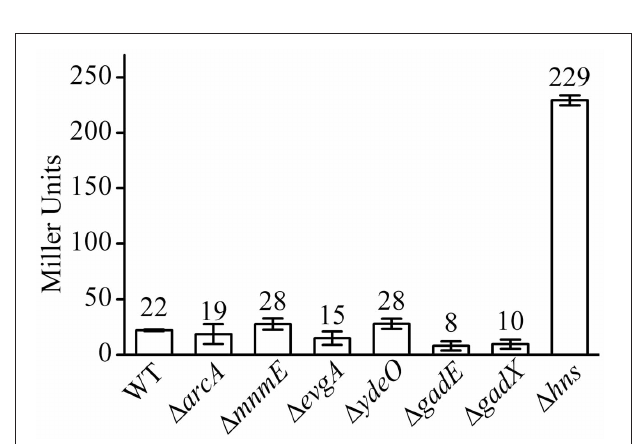
FIGURE 3 | β -galactosidase activity of P gadE-lacZ fusion in WT (MG1655 (cid:2) lacZ ), (cid:2) arcA , (cid:2) mnmE , (cid:2) evgA , (cid:2) ydeO , (cid:2) gadE , (cid:2) gadX , and (cid:2) hns mutant strains under aerobic